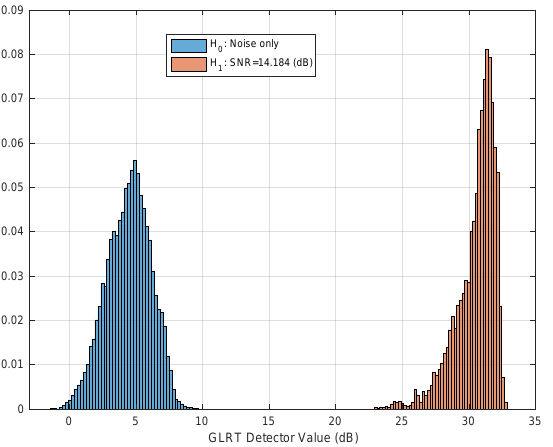
Figure 10. Real example of test hypothesis separation. SNR ∼ = 14 dB. Extracted from an overnight sleep of Baby I.